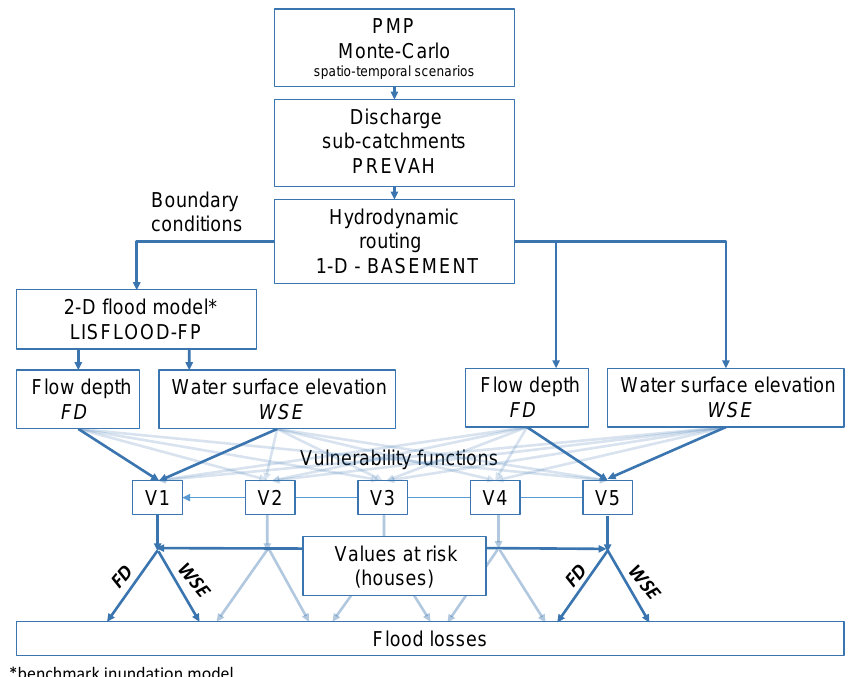
Figure 1. Schematic of the nesting approach. The 2-D flood inundation models and the loss models are nested in a 1-D routing